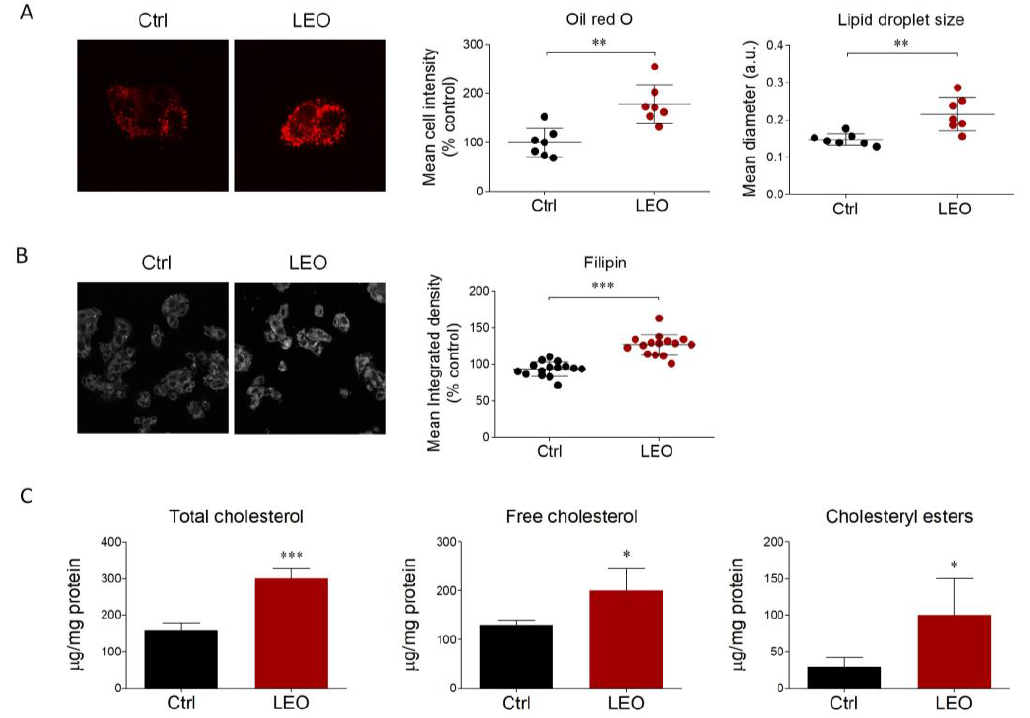
Figure 1. LEO increases the content of neutral lipids and cholesterol in HepG2 cells. ( A ) Representa- tive images of Oil Red O staining (left panel), used to visualize intracellular neutral lipids on HepG2 cells treated with the vehicle (DMSO, Ctrl cells) or LEO (0.005%) for 24 h, and respective quantifica- tion of the mean cell intensity and the mean diameter of lipid droplets (right panel). n = 7 experi- mental replicates. ( B ) Representative images (left panel) and calculation of the mean integrated den- sity (right panel) of filipin signal performed on HepG2 cells after treatments with the vehicle (Ctrl) and LEO (0.005%) for 24 h. n = 15 experimental replicates. ( C ) Quantification of intracellular choles- terol content (total cholesterol, free cholesterol, and cholesteryl esters) in vehicle- and LEO-treated HepG2 cells. n = 5 different experiments. Data represent means ± SD. Statistical analysis was as- sessed using the unpaired Student’s t -test. * p < 0.05; ** p < 0.01; *** p < 0.001. 2.3. LEO Modulates the Expression of Proteins and Enzymes that Control Cholesterol Metabolism Once we had assessed the impact of LEO administration on neutral lipids and cho- lesterol content, the proteins and enzymes that orchestrate cholesterol metabolism were analyzed to provide a mechanistic explanation. The key enzymes involved in cholesterol biosynthesis were assessed using a Western blot test. The protein expression of HMGCR and SQLS was significantly reduced after 24 h of LEO treatment (Figure 2A,B), whereas SQLE did not show any statistically significant change (Figure 2C). The reduction in HMGCR and SQLS suggests a decrease in cholesterol biosynthesis upon LEO stimulation.